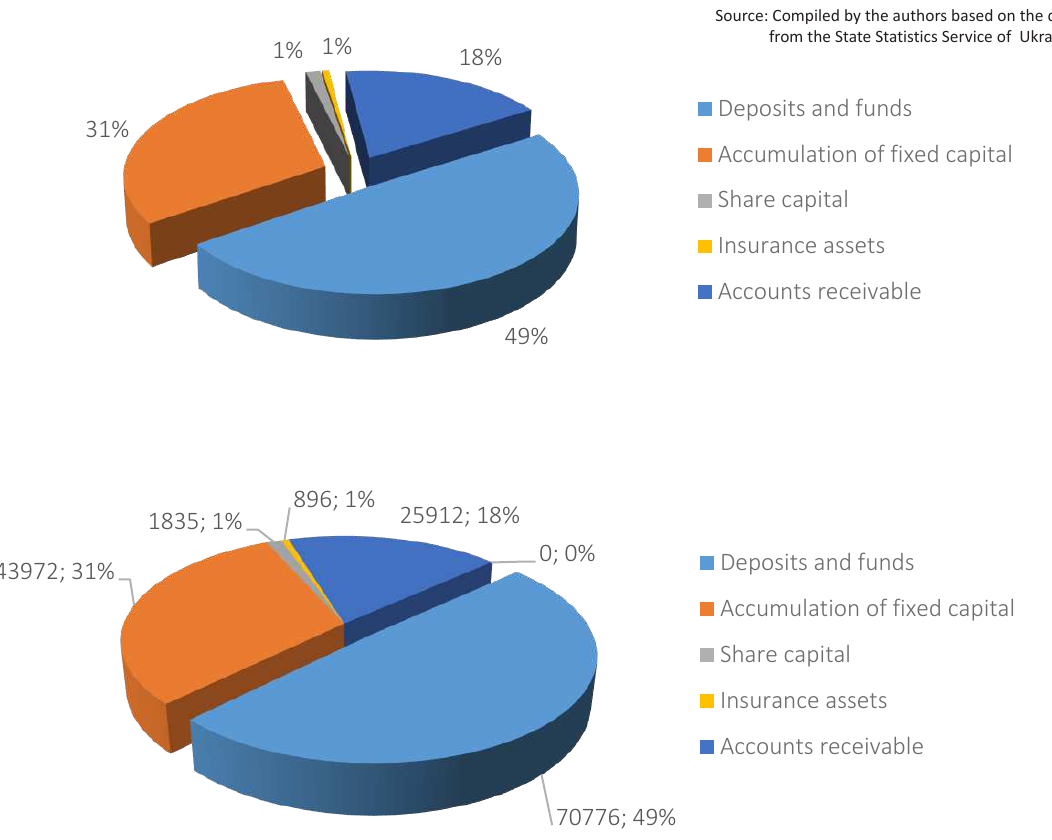
Figure 2. The structure of asset acquisition by households in Ukraine in 2019,